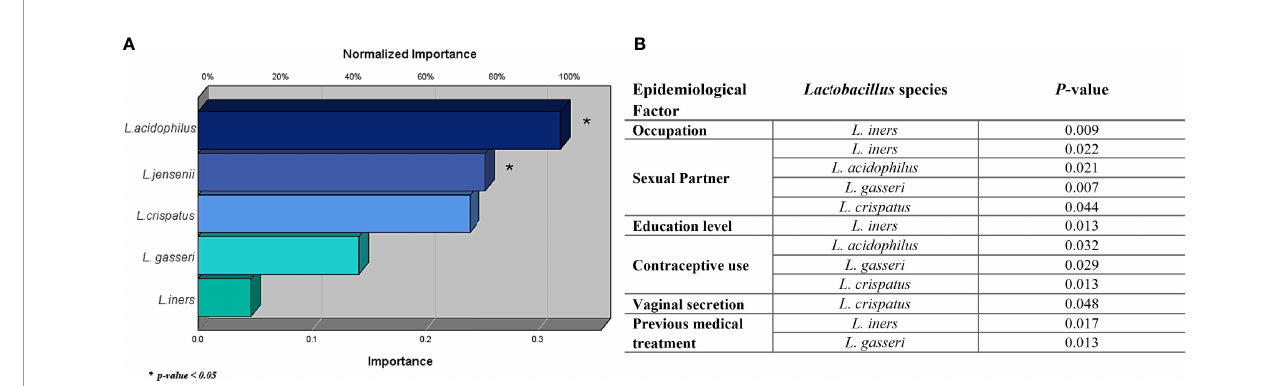
FIGURE 2 | Protective effect of the identi fi ed Lactobacillus sp. against the development of vaginal dysbiosis (A) and their statistical signi fi cance with epidemiological factors (B) evaluated in the study. The effect of each Lactobacillus sp. against the presence of a vaginal dysbiosis case was evaluated using logistic regression, where Lactobacillus acidophilus , Lactobacillus jensenii , and Lactobacillus crispatus show the greatest importance. However, only L. acidophilus and L. jensenii featured a signi fi cant p -value, more exactly, 0.035 and 0.050, respectively. Meanwhile, Lactobacillus gasseri and Lactobacillus iners show a null protective effect against the infection when they are evaluated